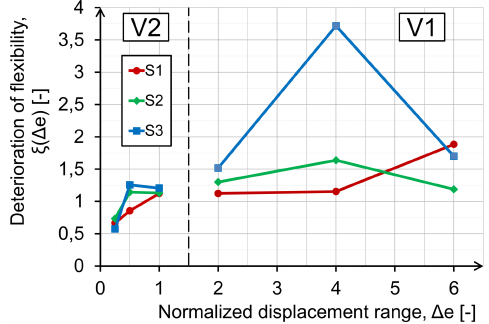
Figure 14: Deterioration of flexibility ξ ( ∆e ) versus relative displace- ment ∆e , evaluated from V1 and V2 loading histories at the load factor 𝛾 1 = 1.5. Table 7: Deterioration of flexibility ξ ( ∆e ) for V1, V2 loading histories at the load factor 𝛾 1 =